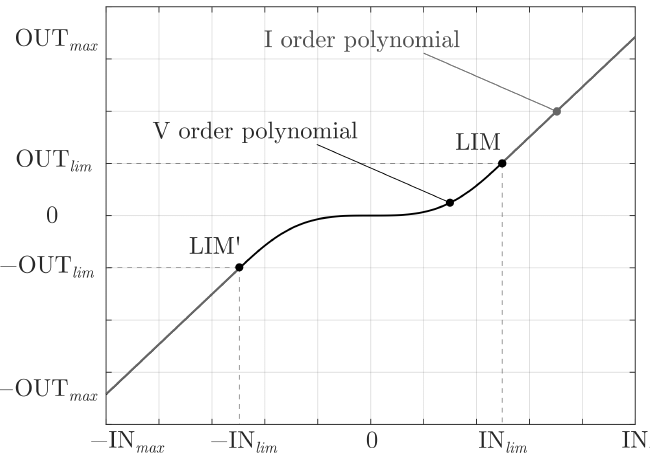
Figure 4. Map function adopted to process the joystick